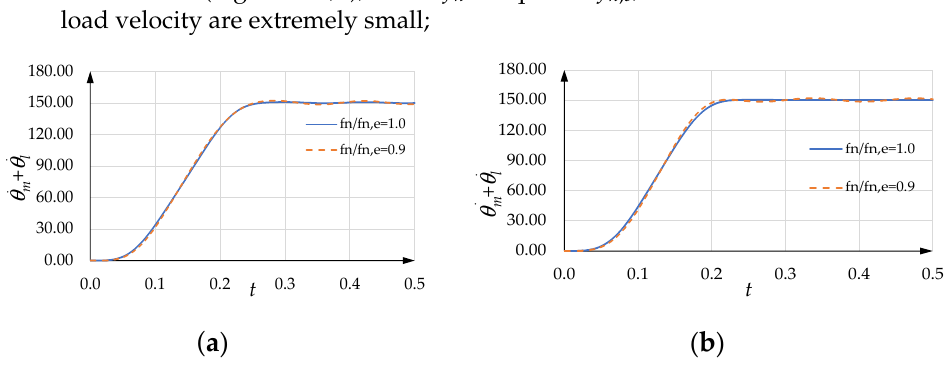
Figure 22. Load velocity versus time: ( a ) J L / J M = 1.00; ( b ) J L / J M = 0.25.